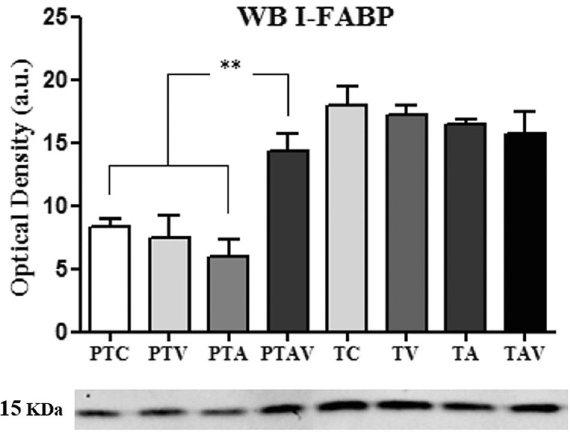
Figure 5. Expression of fatty acid-binding intestinal protein (I-FABP) by optical density (arbitrary units, a.u.) after western blotting in newborn rats (n=6). Observe higher expression in the term subgroups compared to the preterm subgroups, and the increased expression in the PTAV subgroup compared to the other preterm subgroups. PTC: preterm control; PTV: preterm ventilated; PTA: preterm asphyxiated; PTAV: preterm asphyxiated and ventilated; TC: term control; TV: term ventilated; TA: term asphyxiated; TAV: term asphyxiated and ventilated. **P o 0.005, one-way ANOVA followed by the Tukey-Kramer